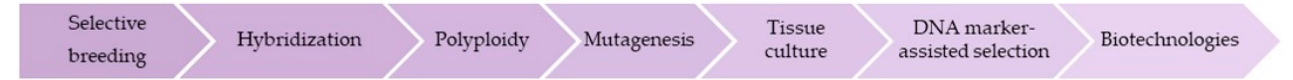
Figure 2. Methods used in developing new lavender genotypes (original flow-chart by Andreea O.).